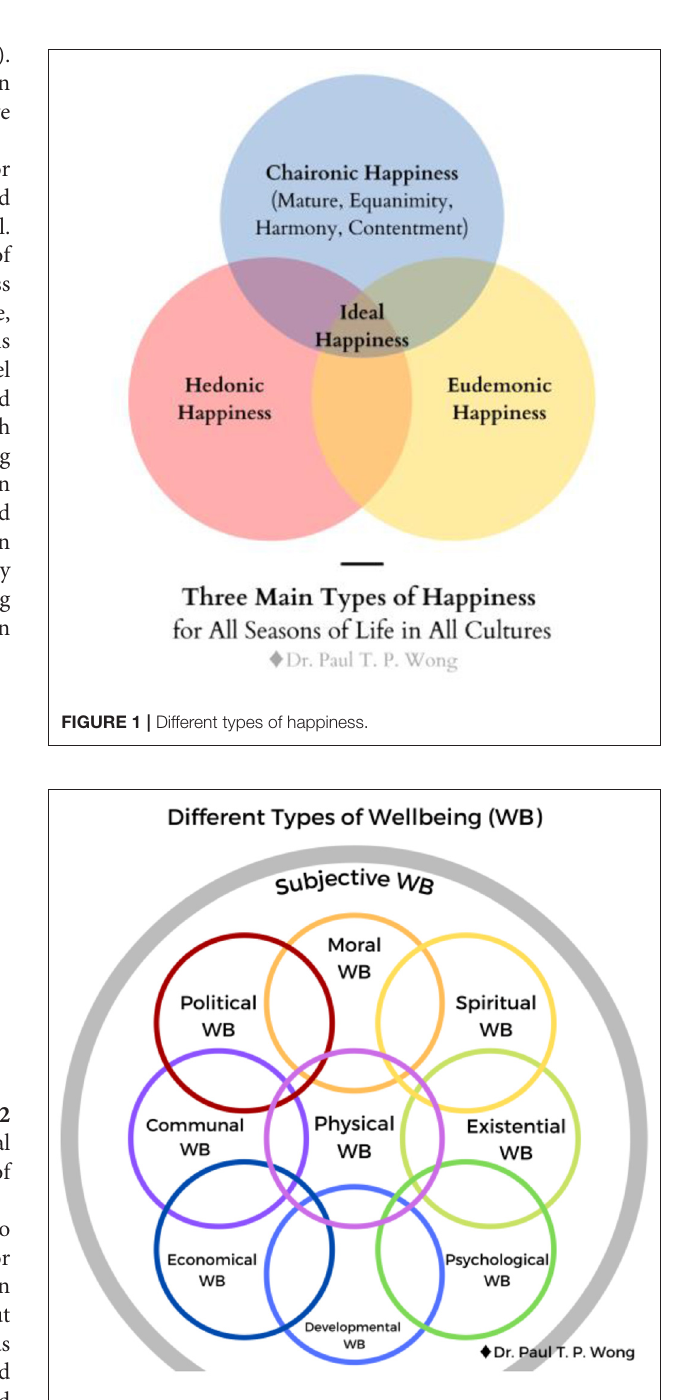
FIGURE 2 | Different types of